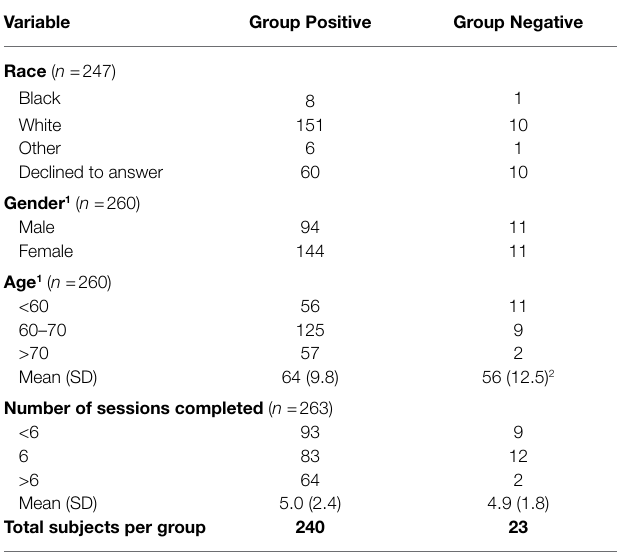
TABLE 4 | Age, number of completed sessions and post-hoc Gender Pairwise t -test on statistically significant differences determined by ANOVA with initial PHQ/GAD scores and survey questions of Group Positive